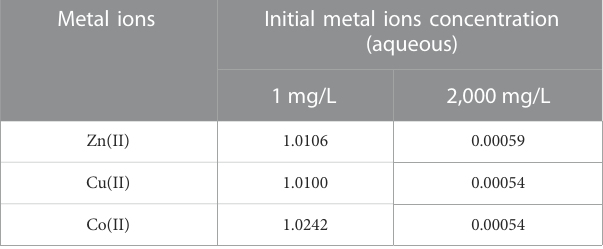
TABLE 3 Separation factor (SF) for sorption of selected metal cations from water samples on SBL. Metal ions